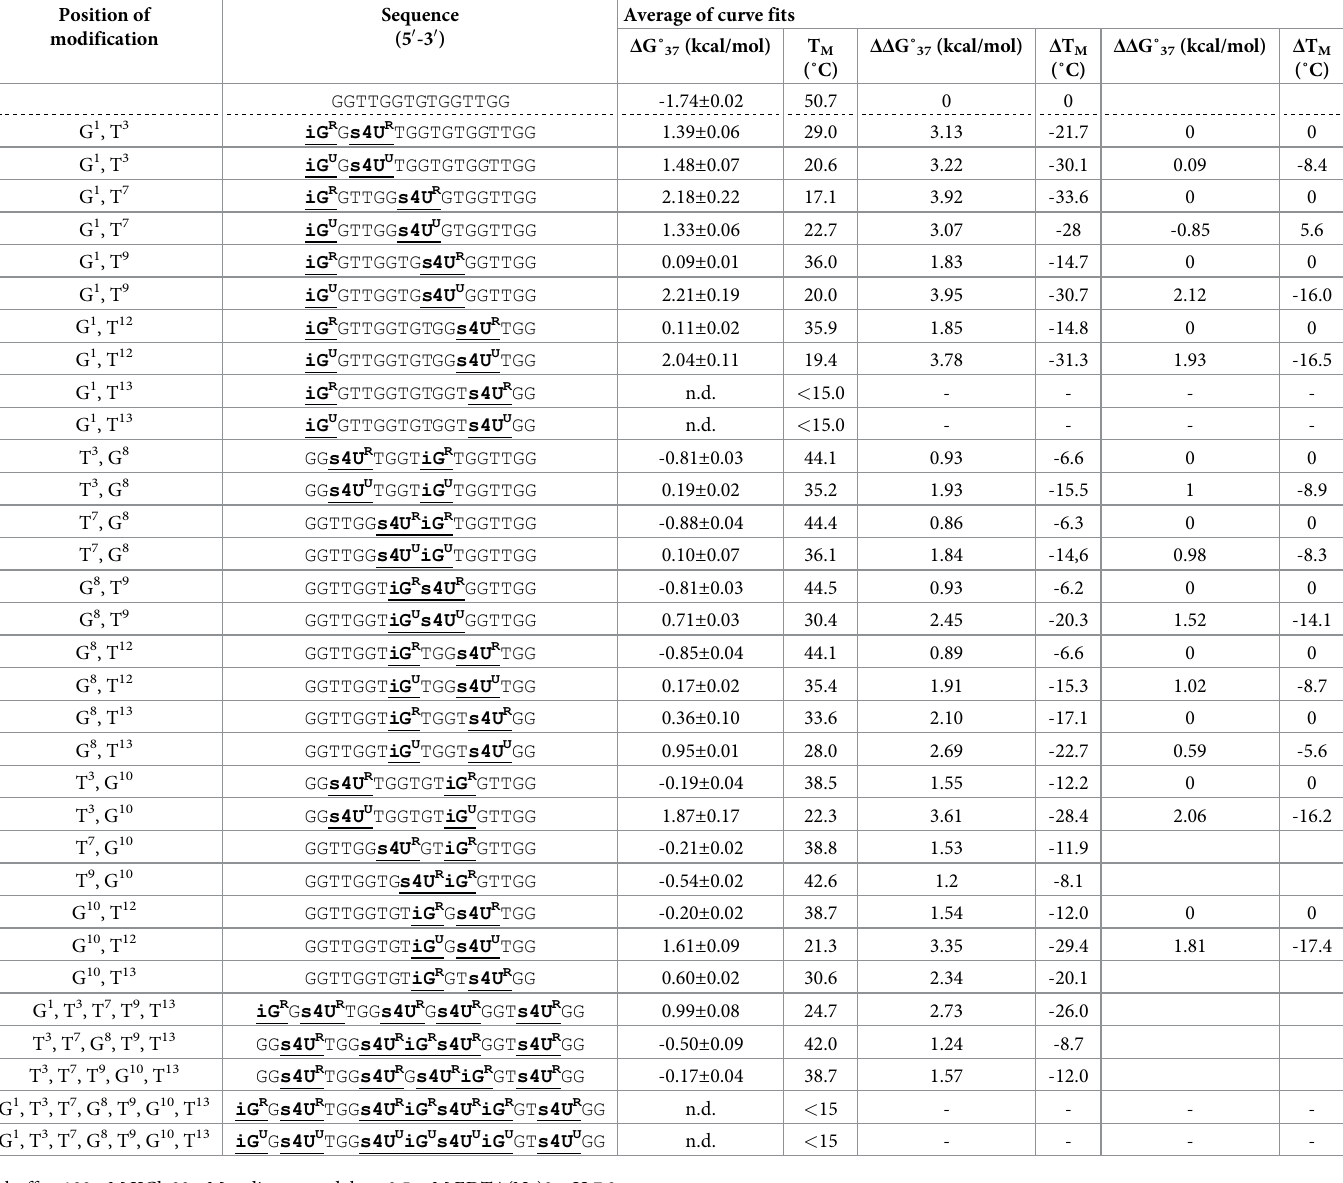
Table 2. Thermodynamic stability of TBA variants modified with RNA-iG and RNA-s4U (iG R ,s4U R ) or UNA-iG and UNA-s4U (iG U ,s4U U ) a . Position of